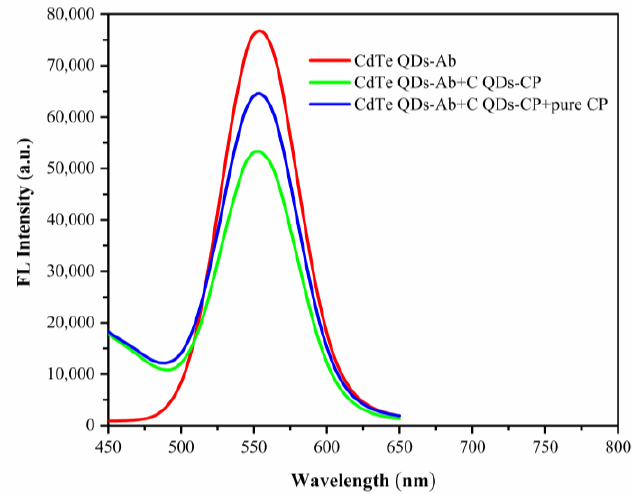
Figure 4. Fluorescence spectra of CdTe QDs-Ab, CdTe QDs-Ab+C QDs-CP, and CdTe QDs-Ab+C QDs-CP+pure CP.